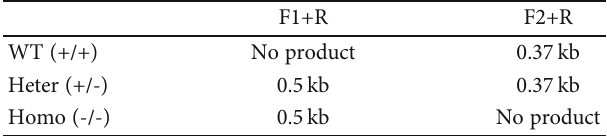
Table 3: Criteria used in genotype determination.